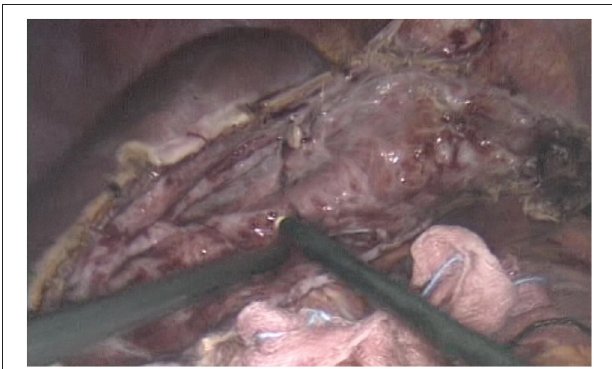
FIGURE 2 | Patient 1 Intraoperative image after completing the cyst